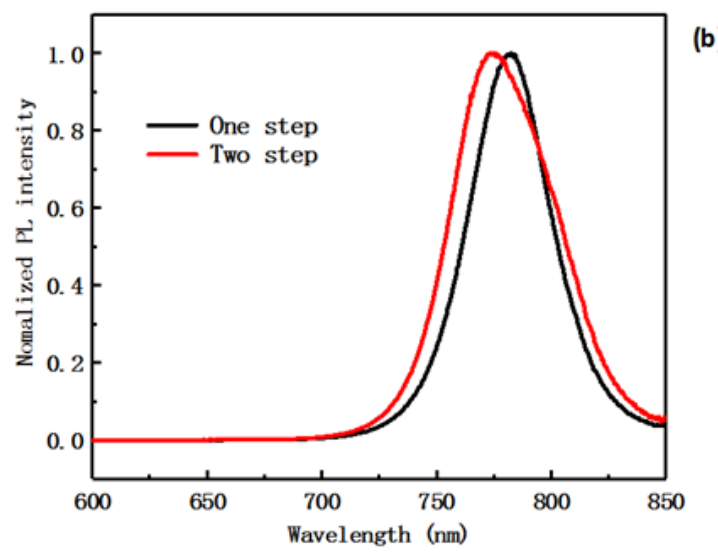
Figure 6. Photoluminescence (PL) spectra of perovskite films with the one-step process method ( a ) and the two-step process method ( b ).